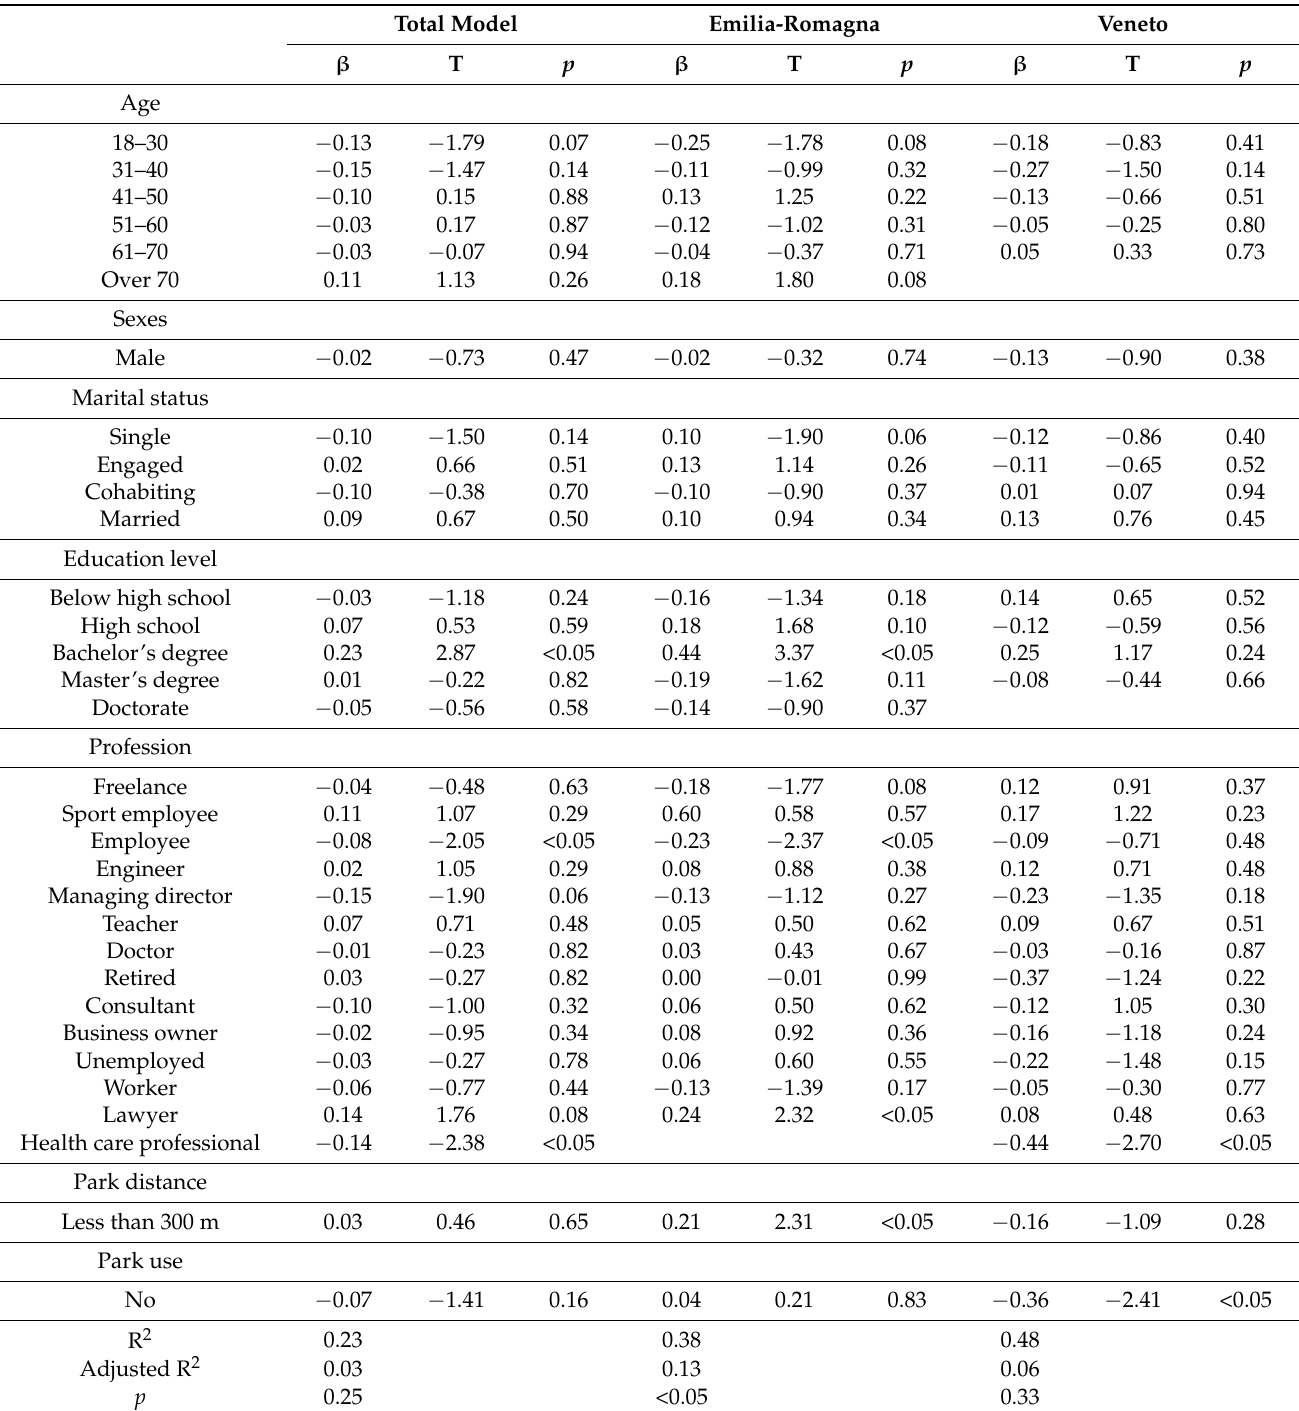
Table 7. Multiple regression for the behavioural